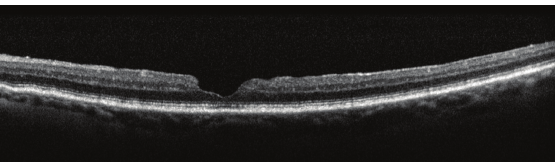
Figure 10: Epiretinal membrane